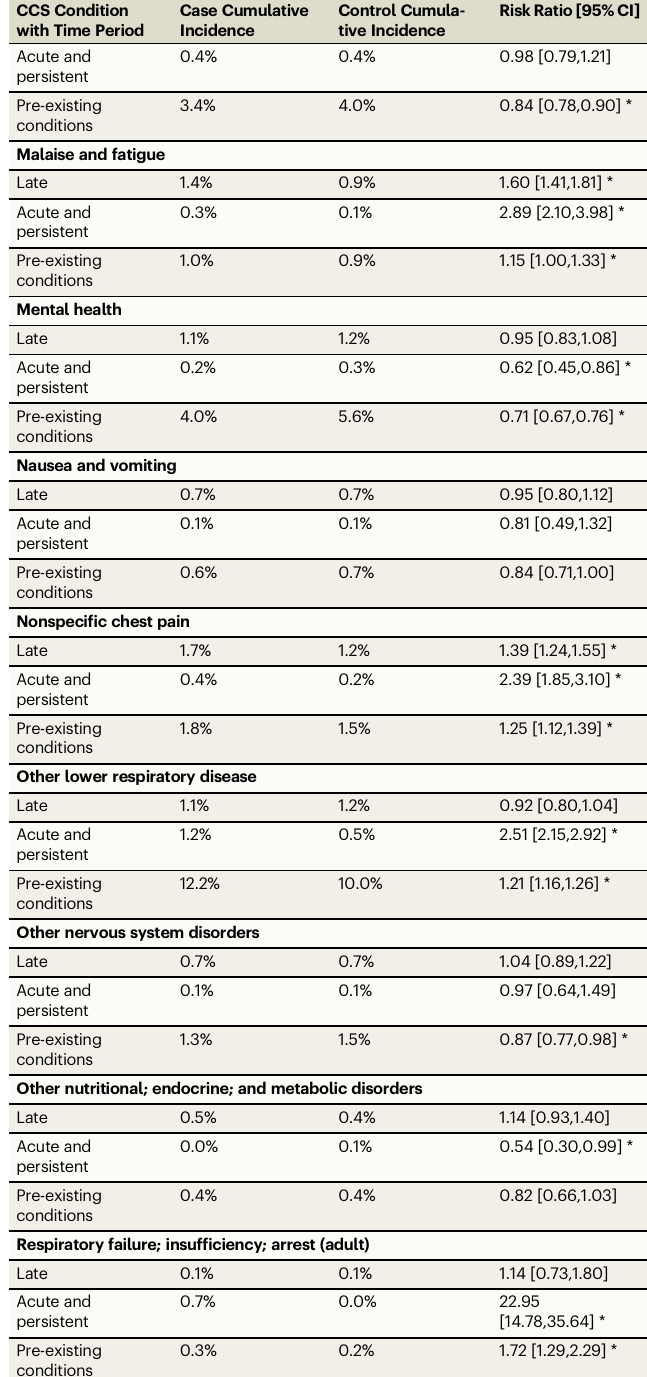
* Represents risk ratios with p <0.05: Timeperiods werede fi ned as follows:Late: 30 – 120 days postCOVIDtestdate;Acuteandpersistent0-30dayspostCOVIDtestdateandpersisted30-120 days; Pre-existing conditions: four yearspriortoCOVID testdate. All risk ratiospresented are